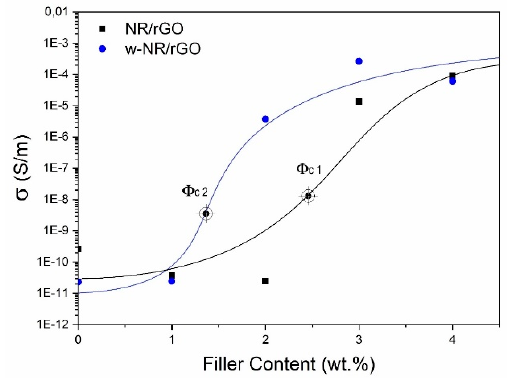
Figure 3. Electrical conductivity of NR/rGO and w-NR/rGO composites as a function of the rGO content.